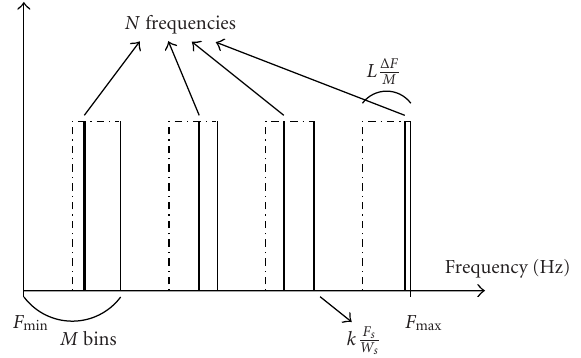
Figure 2: Parameters for the control of the frequency distribution: the number of bins defines the edge of the bins and the bin width is determined by the parameter L